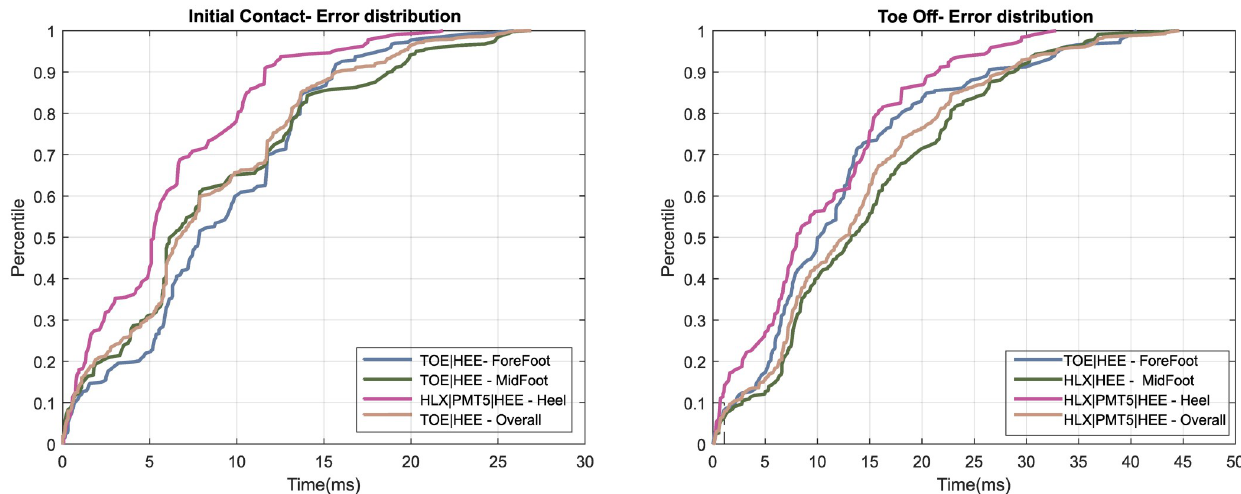
Shown are the mean performances of ten models (for each subgroup and corresponding marker combination) trained on different training/validation splits and evaluated on the same testset. Irrespective of input marker combination, the training variability estimated over 10 training runs with different training/validation dataset-splits (Tables 3 and 4), which were in the order of 2%- 4% for all input markers and all gait groups.